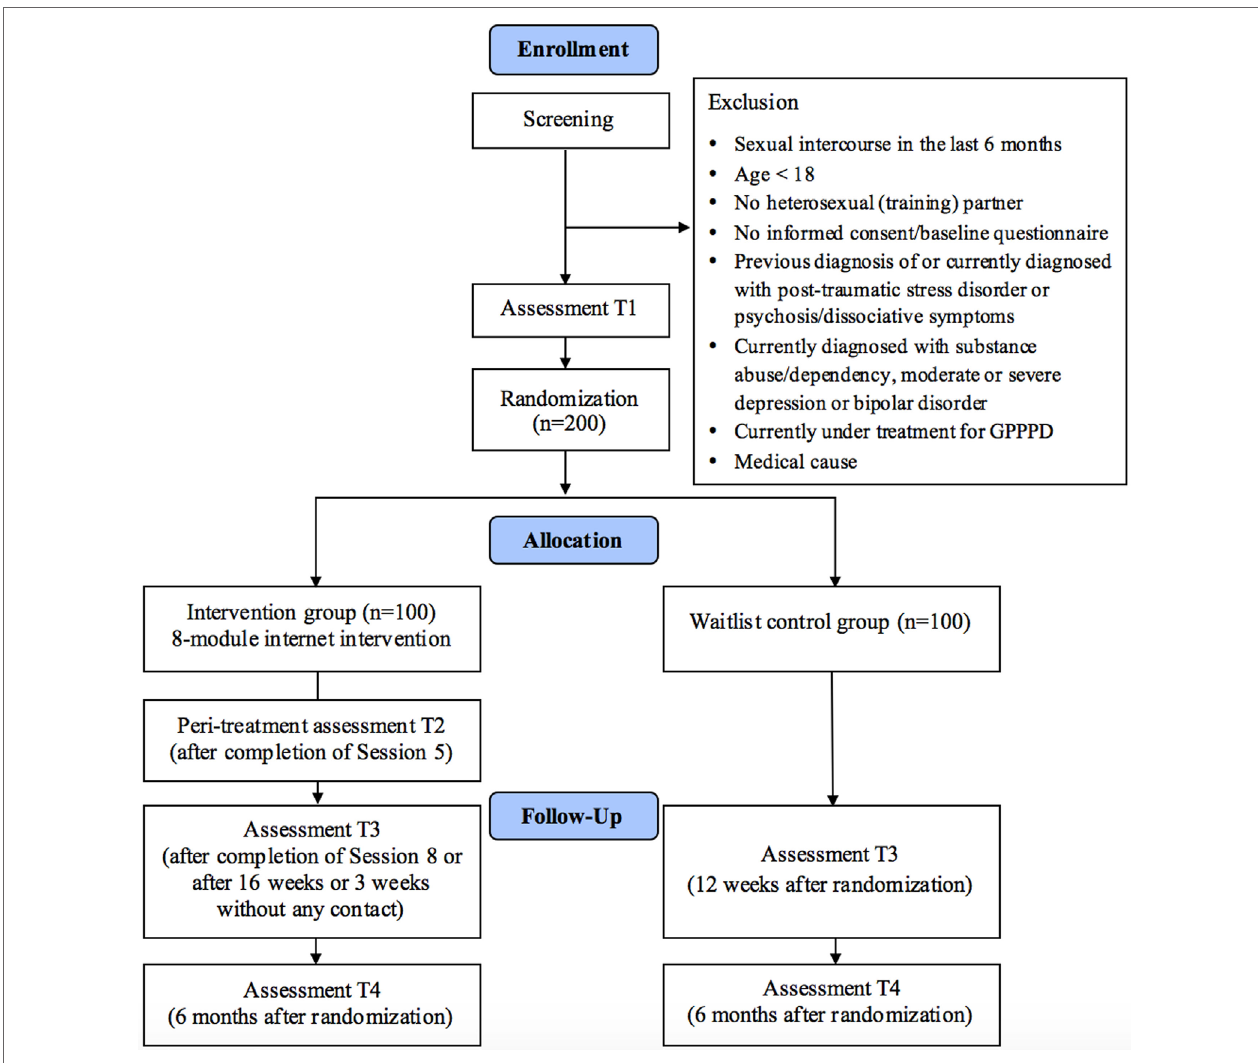
FIGUrE 1 | Flow of